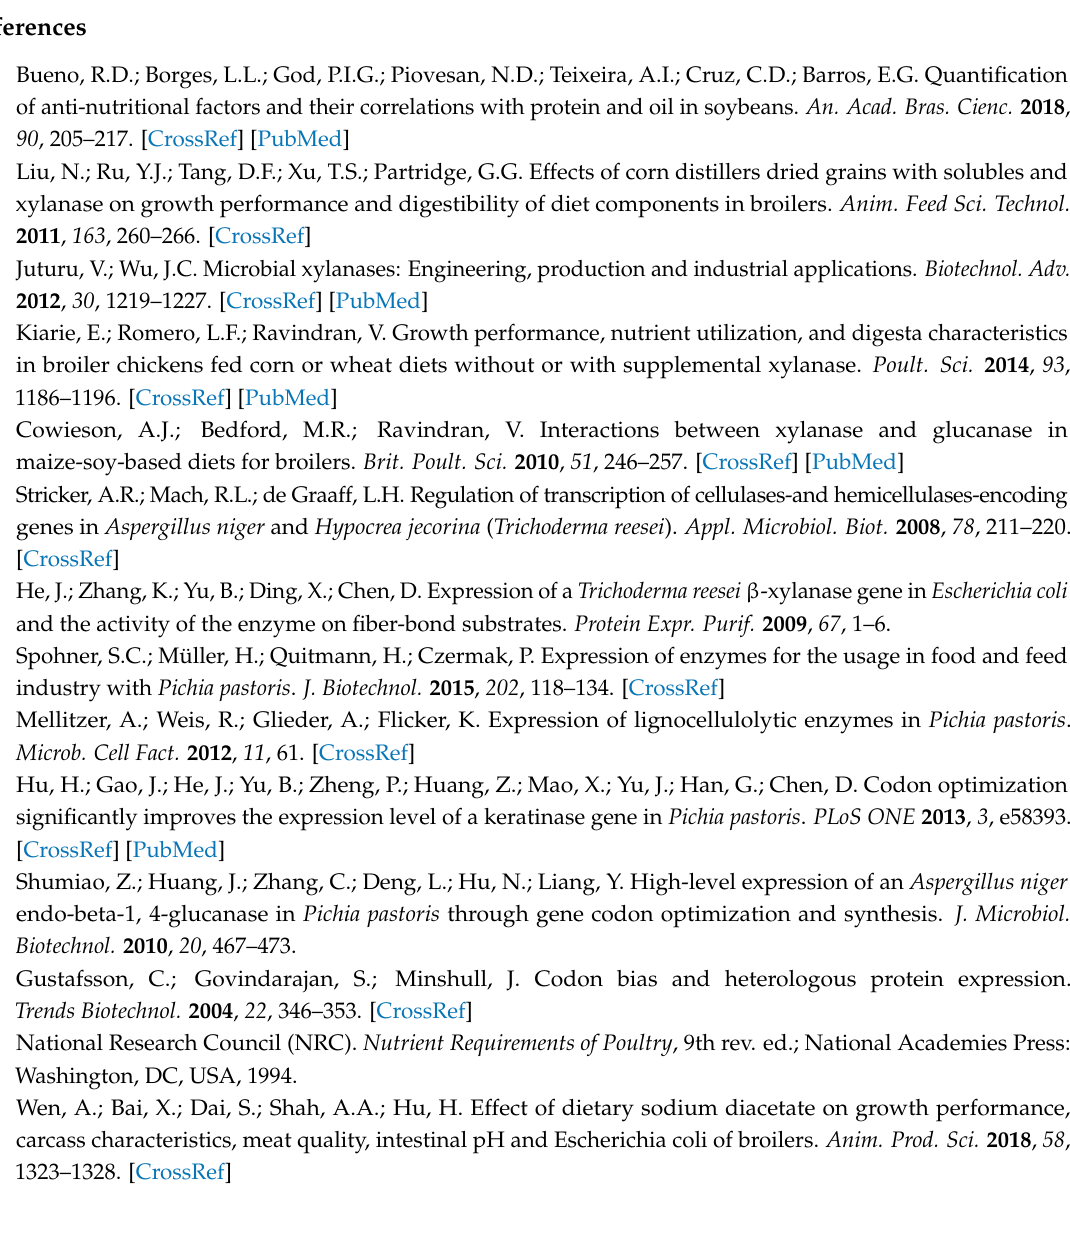
Table S1. Ingredient and composition of basal diets